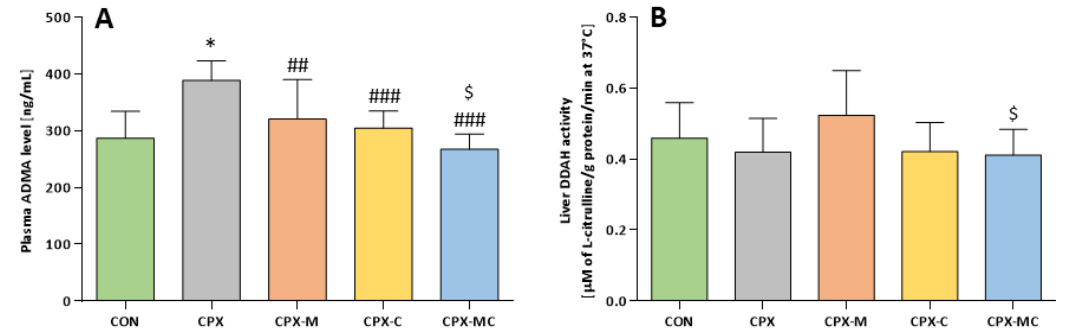
Figure 7. Plasma ADMA level ( A ) and DDAH activity ( B ) in liver homogenates. Data are presented as means ± SD. A detailed description of experimental groups is presented in Figure 1 and in the Materials and Methods section. * p < 0.05 vs. CON; ## p < 0.01, ### p < 0.001 vs. CPX group; $ p < 0.05 vs.